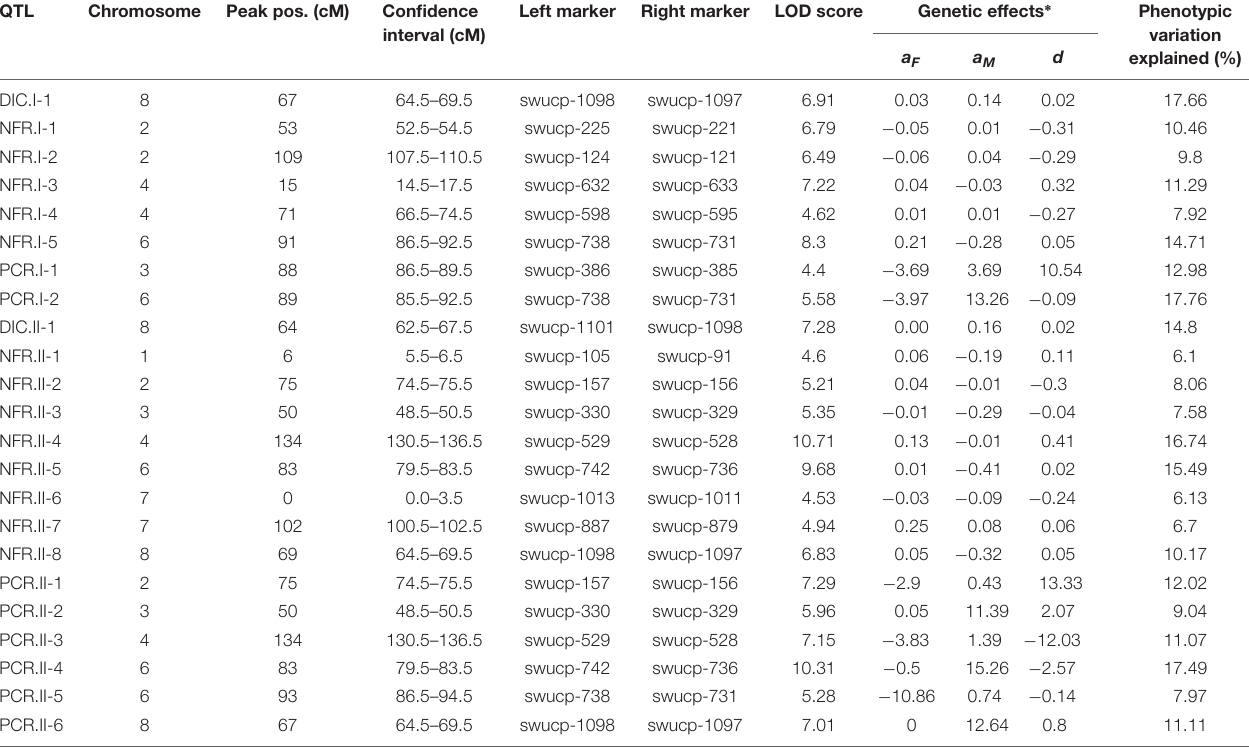
TABLE 4 | Quantitative trait loci (QTLs) for the number of disease incidence (DI), fibrous roots (NFR), the root surface covered with fibrous roots (RFR), and the Plasmodiophora brassicae content in roots (PCR) in Brassica oleracea. QTL Chromosome Peak pos. (cM) Confidence Left marker Right marker LOD score Genetic effects ∗ Phenotypic interval (cM)